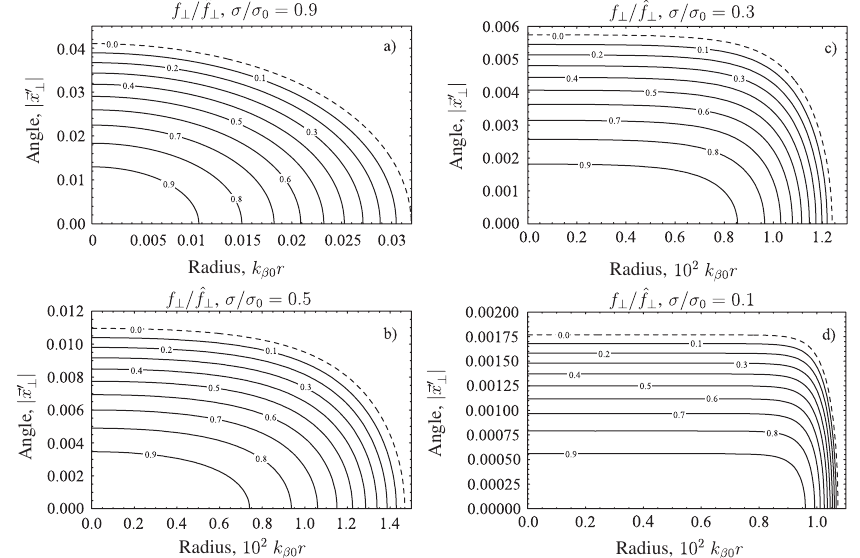
j for the profiles shown in r and j x 0 (cid:5) 0 ? ð H Þ = ^ f ? ? ? , and the edge contour